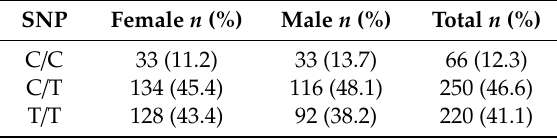
Table 3. TRPV1 -rs8065080 genotype